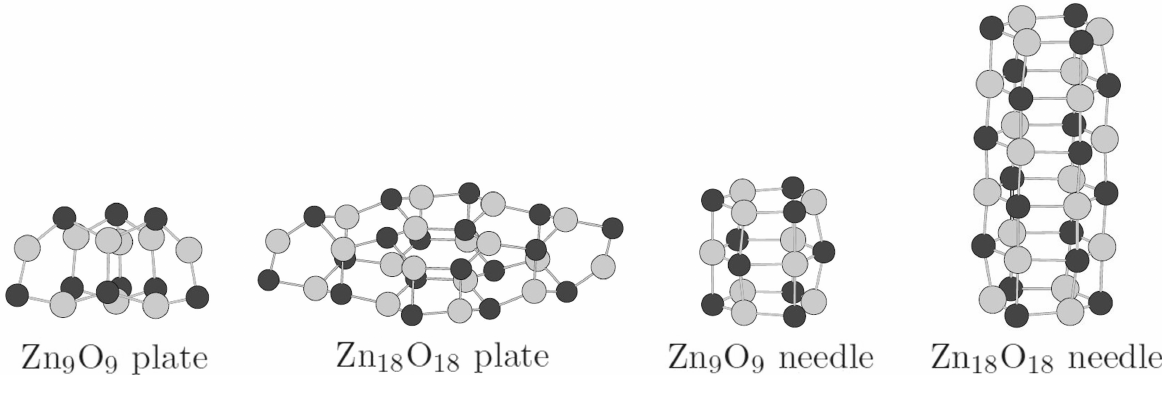
) of ZnO clusters, showing differences between SR O needles, where i = 3, 6, 9, 12, i i